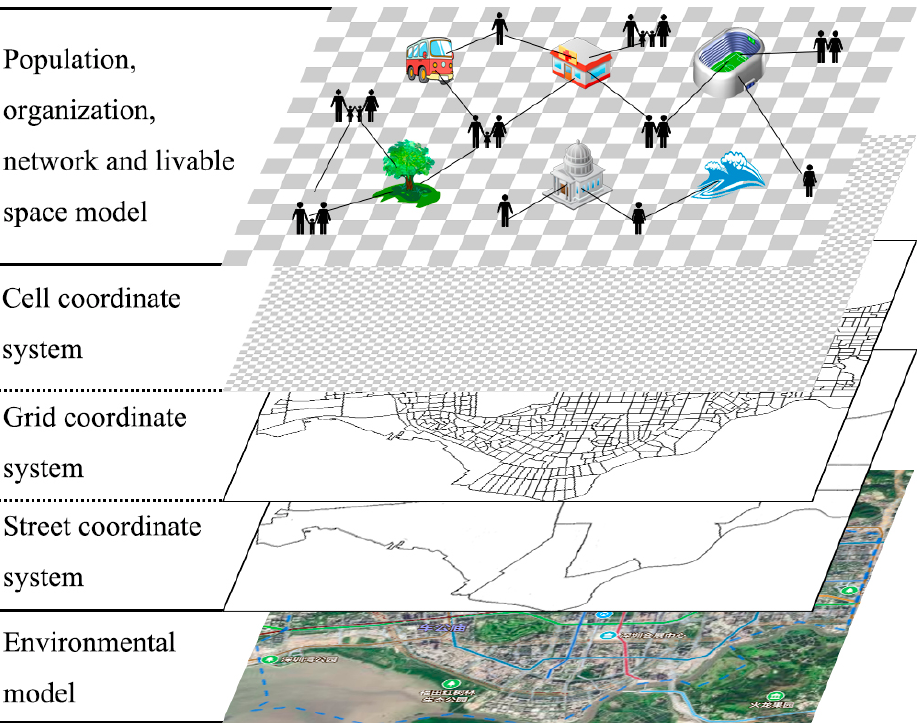
Figure 4. Levels of the social